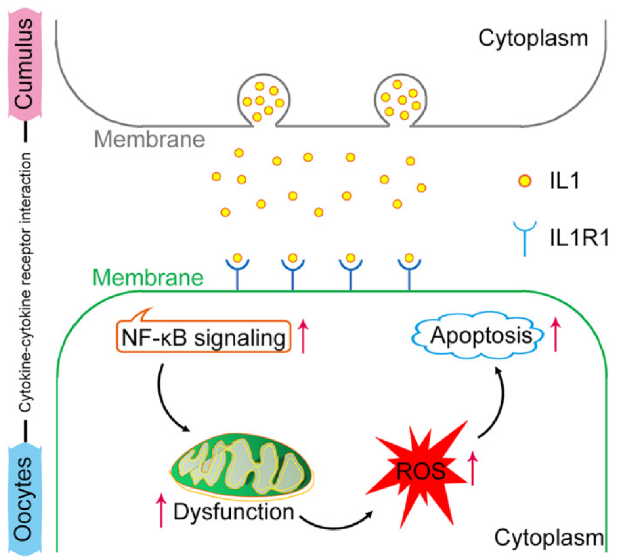
Figure 7. A schematic model showing that the cumulus cells accelerate POA through IL1–IL1R1 in cytokine–cytokine receptor interaction. This activates NF- κ B signaling in oocytes, which in turn causes various abnormalities in oocytes, such as mitochondrial dysfunction, abnormal ROS accumulation, and early apoptosis, ultimately impairing oocyte